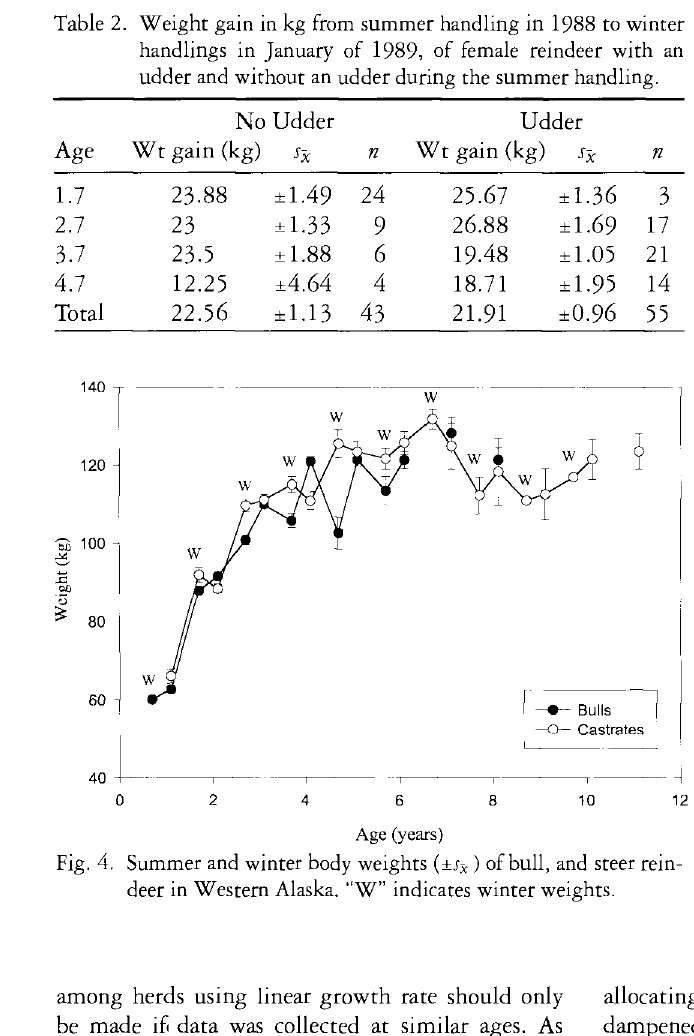
Fig 4. Summer and winter body weights (±s- deer in Western Alaska. "W" indicates winter weights.